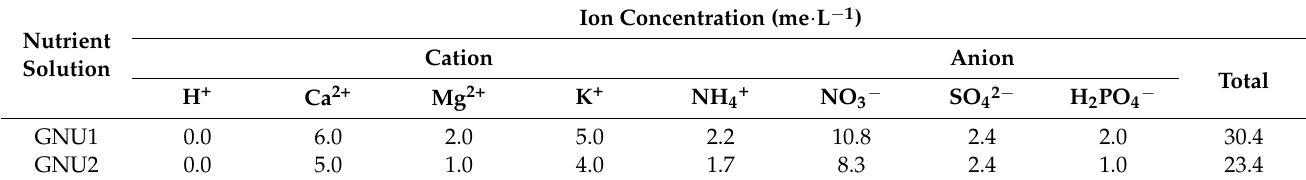
Table 3. Concentrations of macro-element cations and anions used in nutrient solutions in Experiment